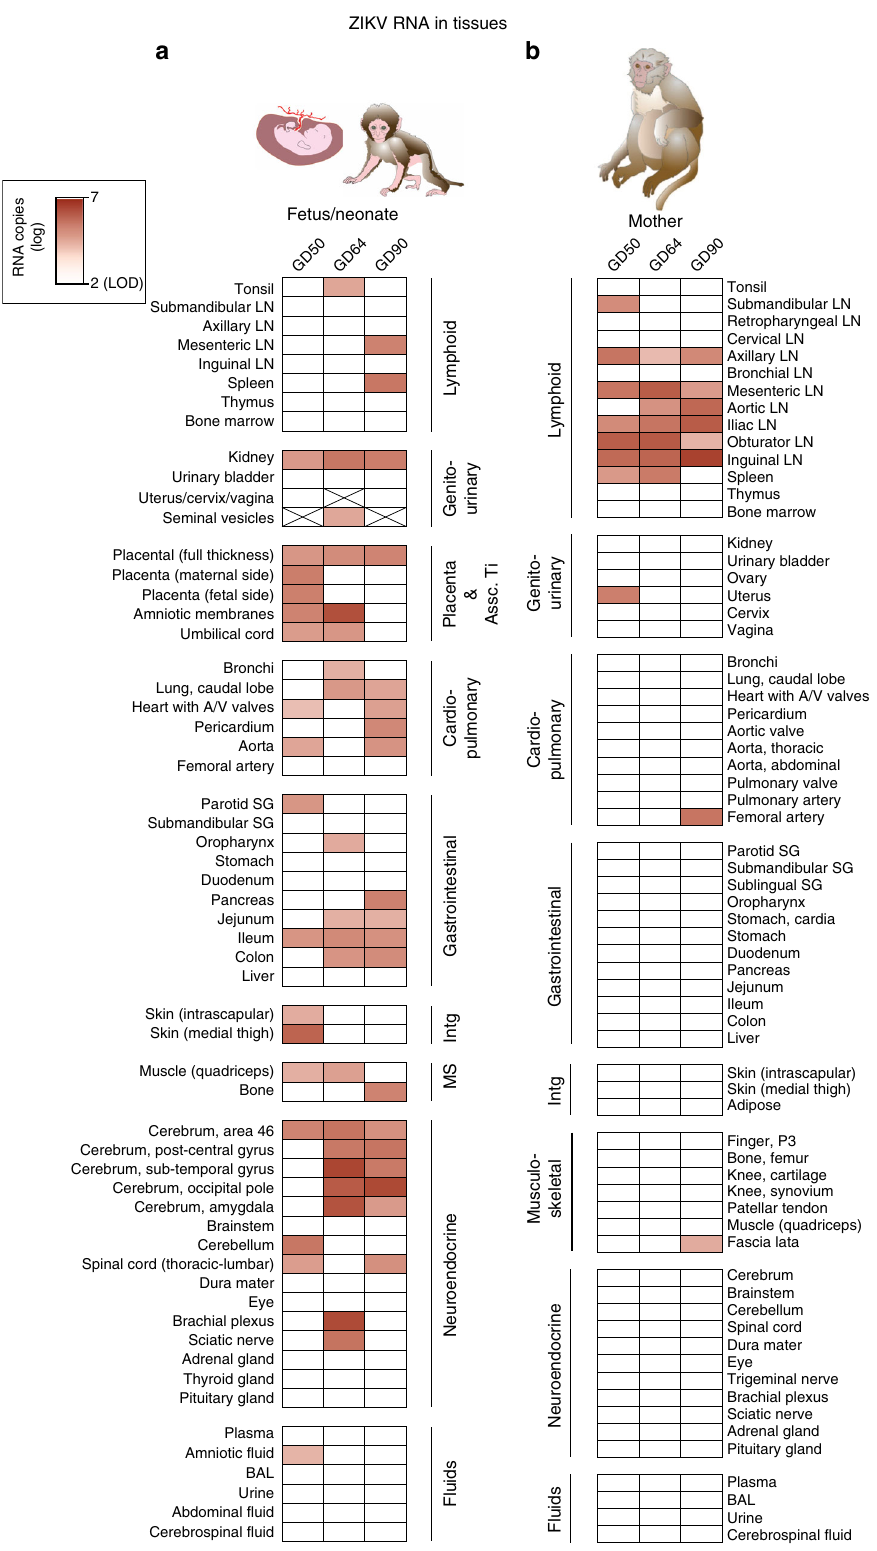
Fig. 4 Tissue tropism of ZIKV RNA differs in fetal macaques compared to their mothers. ZIKV RNA in a fetal/neonatal and b maternal tissues categorized by system. The intensity of red highlights the quantity of ZIKV RNA detected. Absolute ZIKV RNA levels in individual tissues for these animals are shown in Supplementary Figures 5 and 7. Fetal/infant tissues that were not available due to their sex (GD50 and GD90 fetuses were females, GD64 infant was a male) are crossed out. LN lymph node, SG salivary gland, MS musculoskeletal, intg integument, BAL bronchioalveolar lavage, A/V atrioventricular, Assc Ti associated